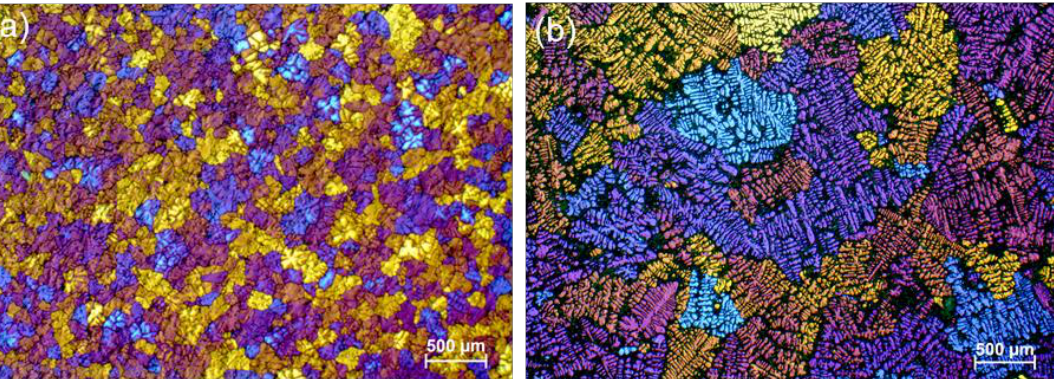
Figure 15. Si poisoning on Al-5Ti-1B grain refiner when its concentration is >3.0% [30]. Optical micrographs showing microstructure of 0.2% Al-5Ti-1B inoculated ( a ) Al-2Si and ( b ) Al-8.4Si alloy solidified in TP-1 mold, showing the much coarser grain size of Al-8.4Si than that of Al-2Si.